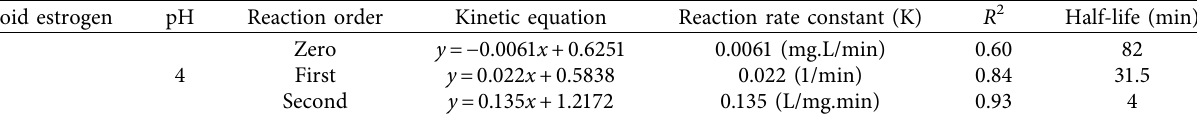
Table 2: Degradation kinetic parameters of E2 under optimum pH.